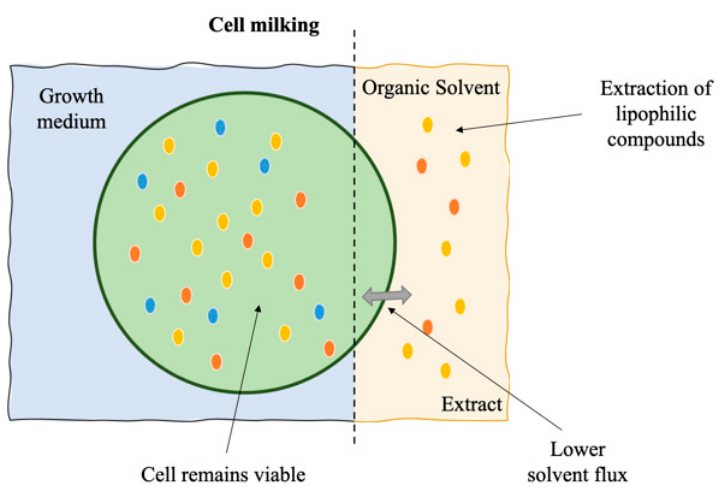
Figure 7. Schematic representation of cell milking in microalgae and cyanobacteria cells.